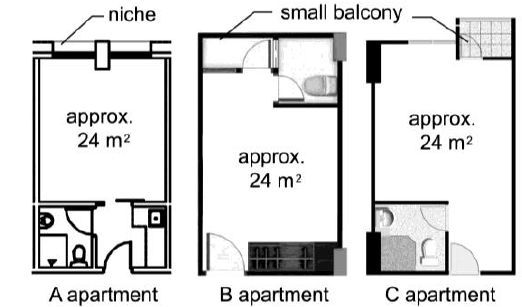
Fig. 6. The room dimensions and layout of A, B and C apartment